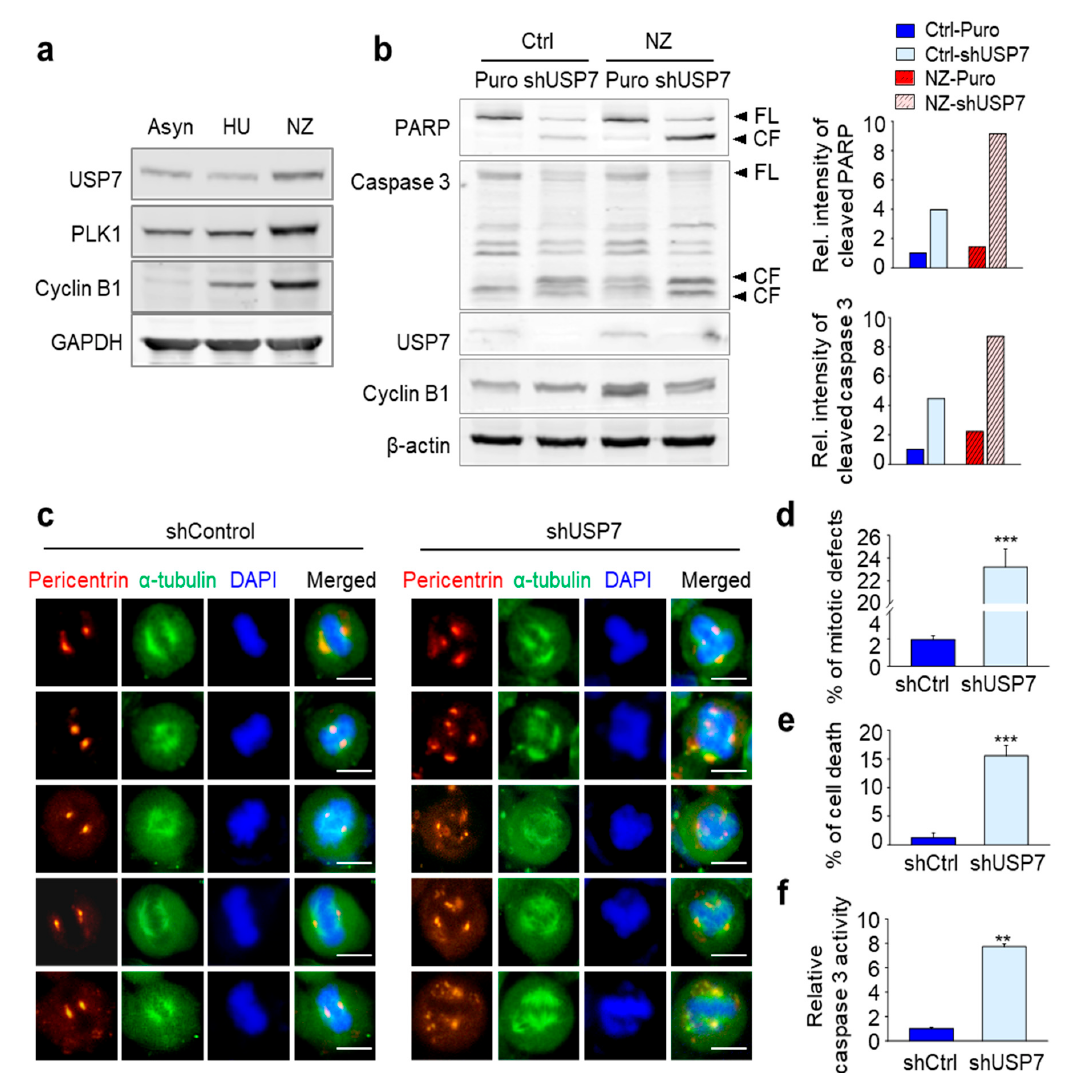
Figure 3. Loss of USP7 results in the formation of multiple spindle poles and, consequently, mitotic catastrophe. ( a ) HeLa cells were treated with 2 mM hydroxyurea (HU) or 100 ng/mL nocodazole (NZ) for 12 h. Asynchronized cells (Asyn) were prepared for comparison. Cell lysates were prepared for Western blot with anti-USP7, anti-PLK1, anti-cyclin B1, and anti-GAPDH antibodies. ( b ) HeLa cells were treated with 100 ng/mL nocodazole (NZ) for 12 h to synchronize mitosis, and then cells were infected with lentiviral USP7 shRNA for 48 h. Then, cell lysates were subjected to immunoblotting. The levels of cleaved PARP and cleaved caspase 3 were detected using anti-PARP and anti-caspase 3 antibodies (left panel). The relative band intensities were quantified using LI-COR Odyssey software (Li-COR Biosciences), normalized, and plotted (right panel). ( c ) HeLa cells grown on coverslips were infected with lentiviral USP7 shRNA or control virus. At 9 h after release from the double thymidine block, cells were fixed with 4% paraformaldehyde and stained with anti-pericentrin (Abcam; red) and anti- α -tubulin (Sigma; green). DAPI was used for staining nuclei. Bar scale, 10 µm ( d ) Quantification of mitotic-defective cells with multipolar spindles with greater than two pericentrin foci in USP7-depleted cells; n > 1000 cells. ( e ) Quantification of apoptotic cells with characteristic apoptotic nuclear morphology such as nuclear condensation in USP7-depleted cells; n > 1000 cells. ( f ) Cell lysates were subjected to a fluorometric caspase 3 activity assay. The means ± SDs (error bars) of data from at least three experiments are shown. (** p ≤ 0.01; *** p ≤ 0.001).